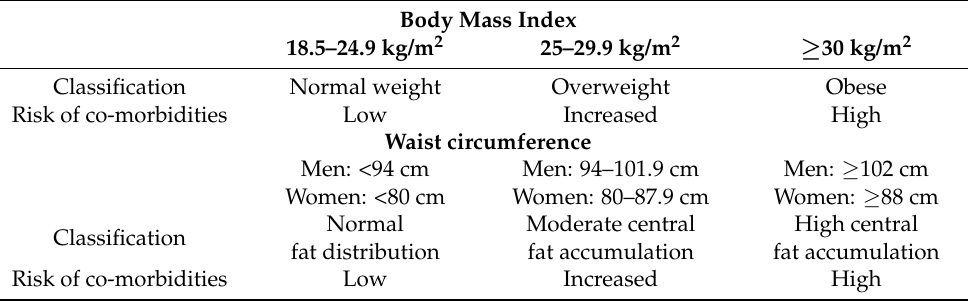
Table 1. Body mass index and waist circumference: cut-offs and risk of